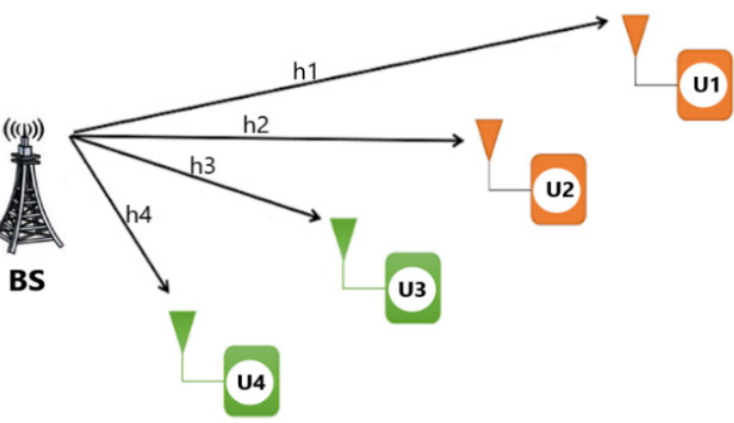
Figure 3. Hybrid-NOMA pairing strategy.